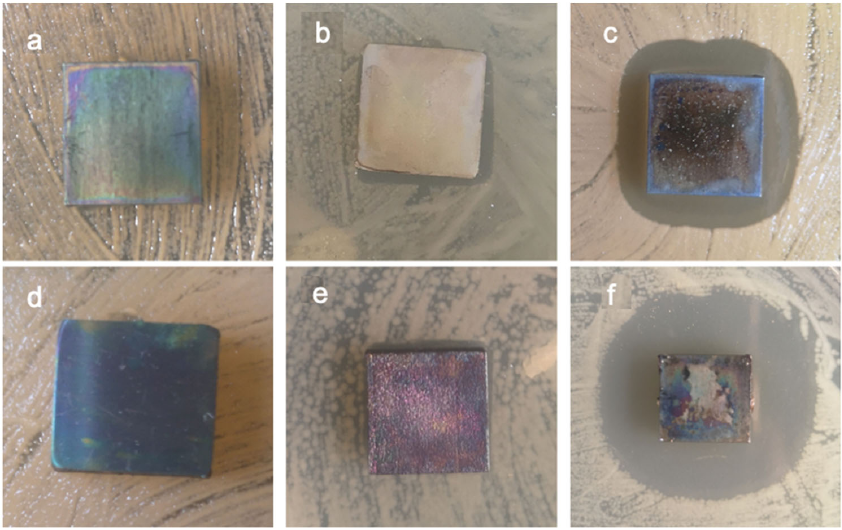
Figure 5. The zone of inhibition (ZOI) of E. coli. ( a – c ) and S. aureus. ( d – f ) after incubation with original titanium alloy ( a , d ), Ti ‐ gel ( b , e ), and Ti ‐ gel ‐ AgNPs ( c , f) .